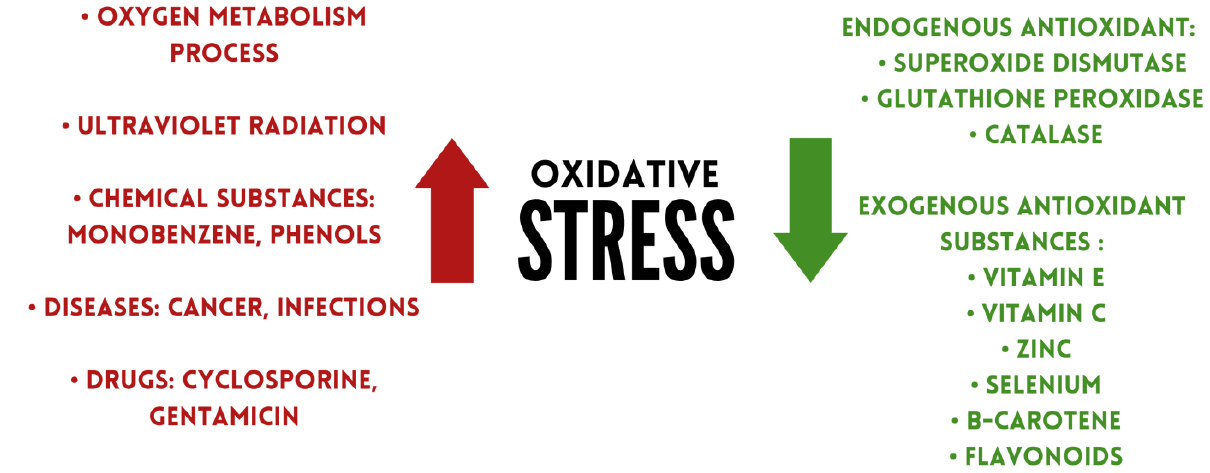
Figure 1. Factors affecting oxidative stress levels .